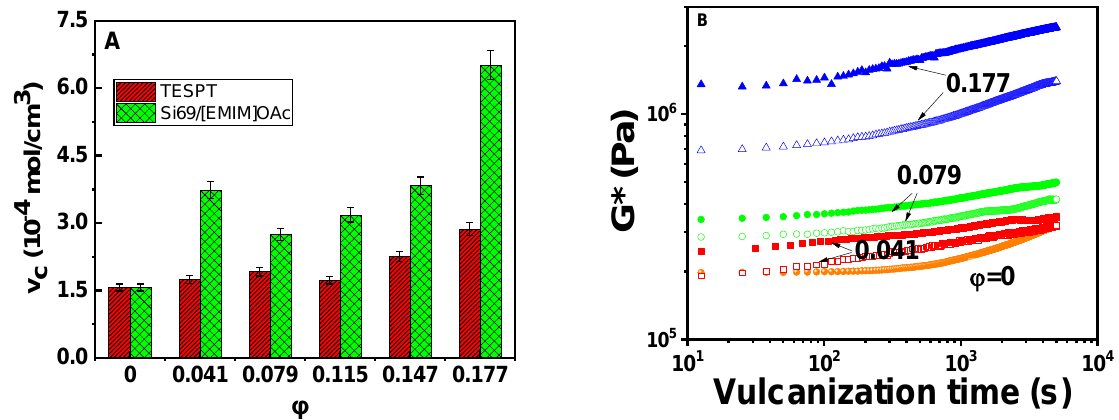
Figure 2. ( A ) Crosslinking density ( v c ) of nitrile butadiene rubber (NBR) in the vulcanizates and ( B ) complex modulus ( G *) of the nanocomposites containing bis( γ -triethoxysilylpropyl) tetrasulfide (Si69) (hollow symbols) or Si69 / 1-ethyl-3-methylimidazolium acetate ([EMIM]OAc) coupling agent (solid symbols) against vulcanization time.